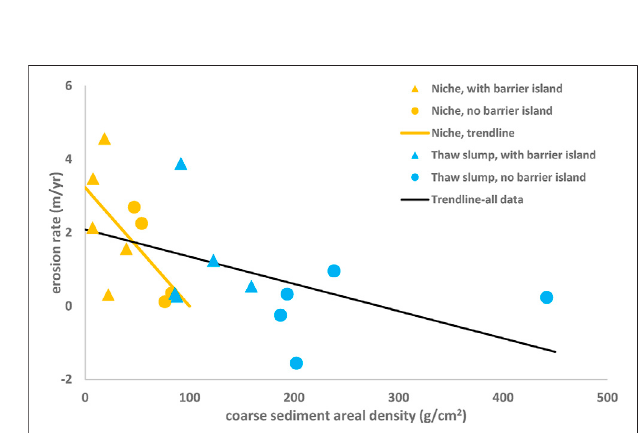
FIGURE 12 | Dependence of coastal erosion rates for the 1980 – 2000 time period on coarse sediment areal density, for sites experiencing niche erosion/block collapse and bluff face thaw/slump. Note, the fi gure provides data on coastal sites that are protected by barrier islands as well as ones without protection as indicated in the legend. Trend linesareprovided for sites with niche erosion/block collapse (orange line, R 2 (cid:2) 0.37) as well asconsidering all sites (black line, R 2 (cid:2) 0.25). For bluff face thaw/ slump sites, the correlation was negligible (R 2 (cid:2) 0.09) and no trend line is